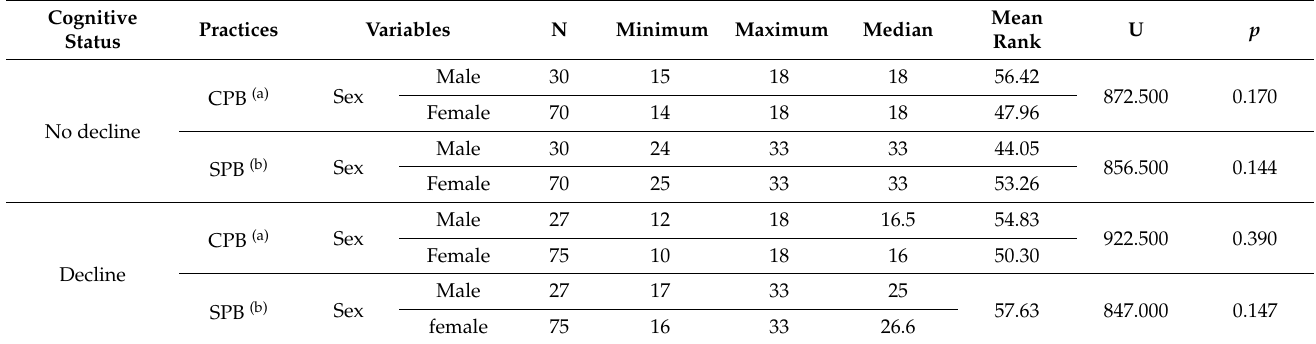
Table 3. Results of the Mann–Whitney U test relative to the practices and behaviors adopted by older adults to manage the risk of falls, by sex. Lisbon;